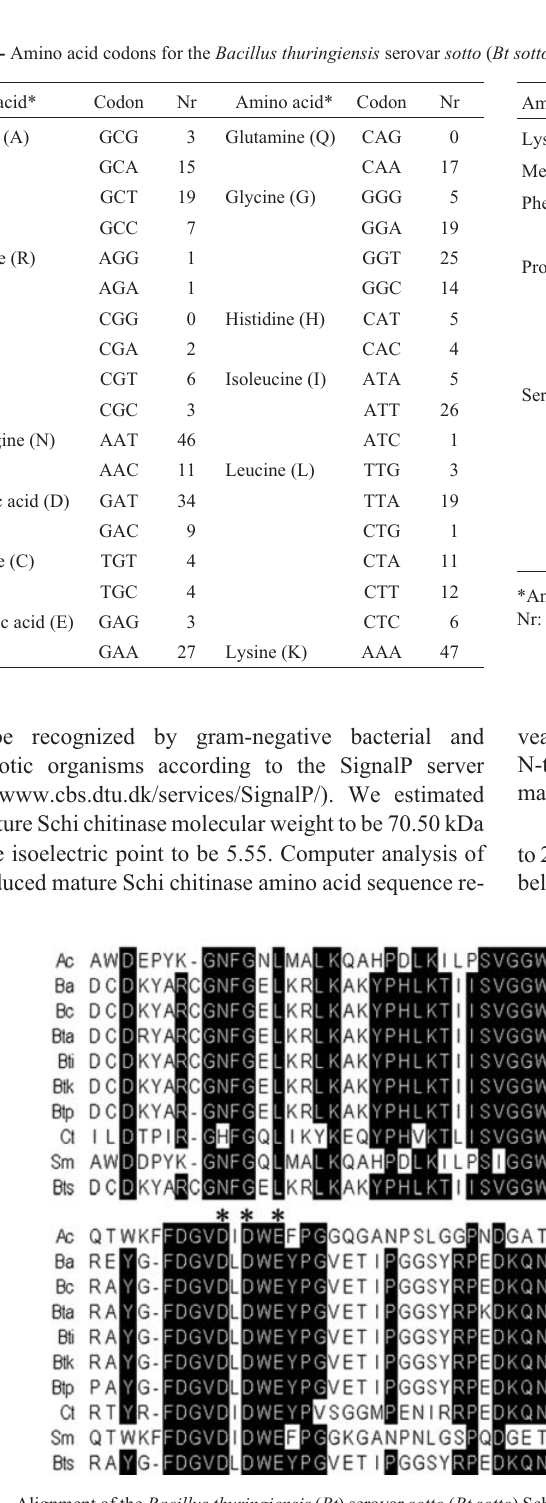
Figure 1 - Alignment of the Bacillus thuringiensis ( Bt ) serovar sotto ( Bt sotto ) Schi catalytic domain with those of other chitinases (Chi). Sequences are from Aeromonascaviae chitinase( Ac ), Bacillusanthracis chitinaseB( Ba ), Bacilluscereus chitinaseB( Bc ), Btalesti ChiA74-HD16( Bta ), Btisraelensis Ichi chitinase ( Bti ), Bt kenyae ChiA74 ( Btk ), Bt pakistani ChiA71 ( Btp ), Clostridium thermocellum ( Ct ) and Serratia marcescens ChiA ( Sm ). Putative protondonoraminoacidresiduesaremarkedwithanasterisk.Dashesindicatedgapsinsertedtoimprovealignment.Numbersrefertotheaminoacidresi- due at the end of the respective lines.